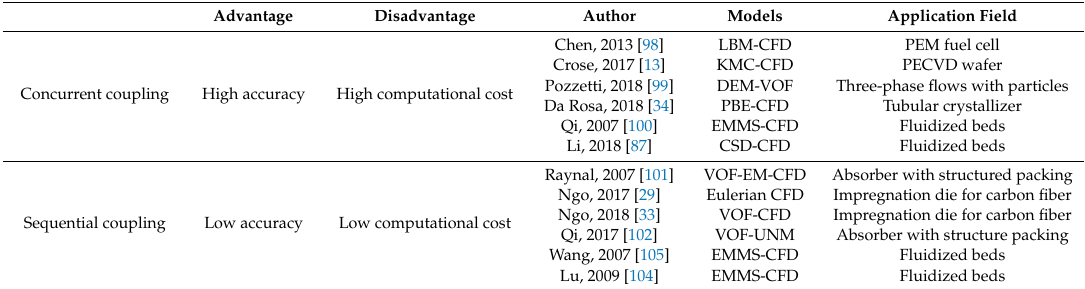
Table 6. Recent progress of multiscale CFD simulation of chemical and biological